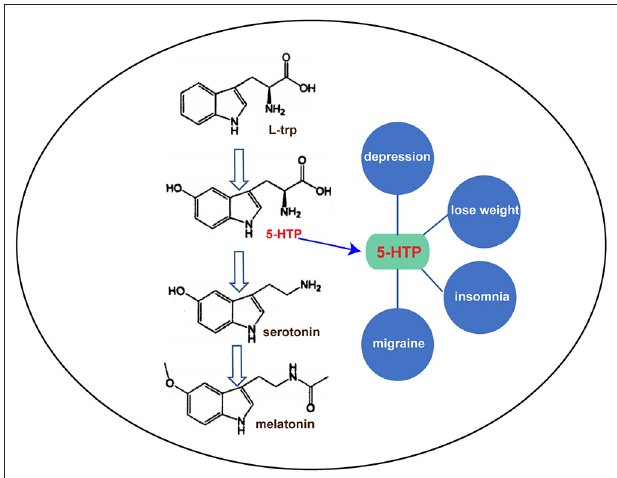
FIGURE 1 | The 5-HTP metabolic pathway and its